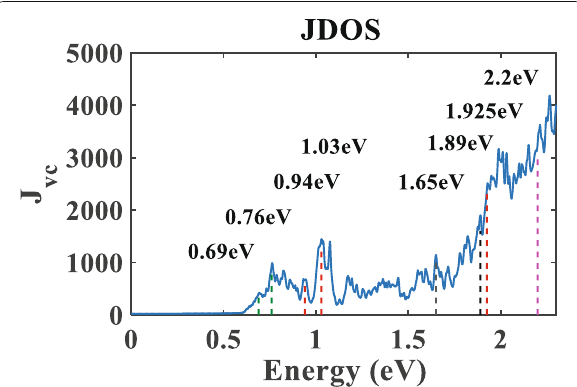
Fig. 4 Joint density of states of nitrogen-doped monolayer MoS 2 . The dotted lines label the critical points of energies exceeds 0.5 eV, series of peaks in JDOS arise. In Fig. 4, two peaks arise at photon energies 0.69 eV and 0.76eV (see green dotted lines). This correspond to the mini- mum energy to excite an electron from the valence band to the impurity band at the high symmetry point Y and (cid:6) [see Fig. 2b], respectively. Furthermore, peaks are also observed when photon energies take the values of 0.94 eV, 1.03 eV, and 1.925 eV. They correspond to optical excitations of electrons from the impurity band to the conduction band at the high symmetry point Y, (cid:6) , and S respectively. In addition, the peaks at 1.65 eV and 1.89 eV (black dotted lines) correspond to the electronic transi- tion from the valence band to the conduction band at high symmetry point Y and (cid:6) respectively. After 1.89 eV, JDOS increases sharply like exponential function, whose trend is in accordance with experiment of optical absorptivity